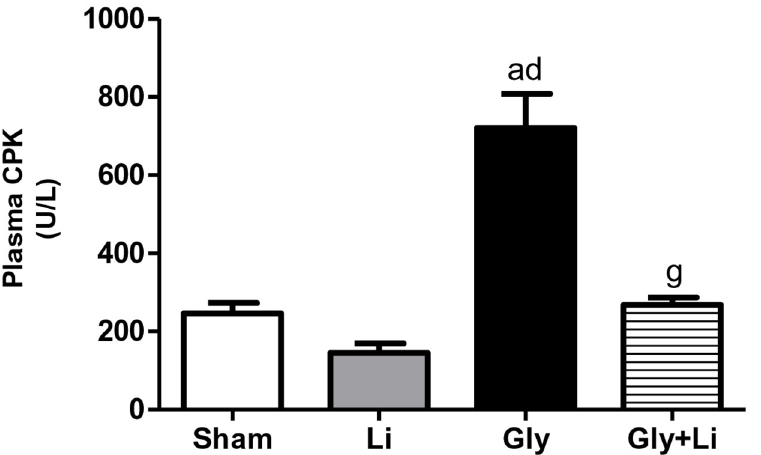
Fig 2. Plasma concentration of Creatine Phosphokinase (CPK) evaluated at the end of the 24h protocol in Sham, Li, Gly and Gly+Li rats. Values are means ± SEM. a p < 0.001 vs Sham; d p < 0.001 vs Li; g p < 0.001 vs. Gly. Li, lithium; Gly, glycerol; Gly+Li, glycerol +